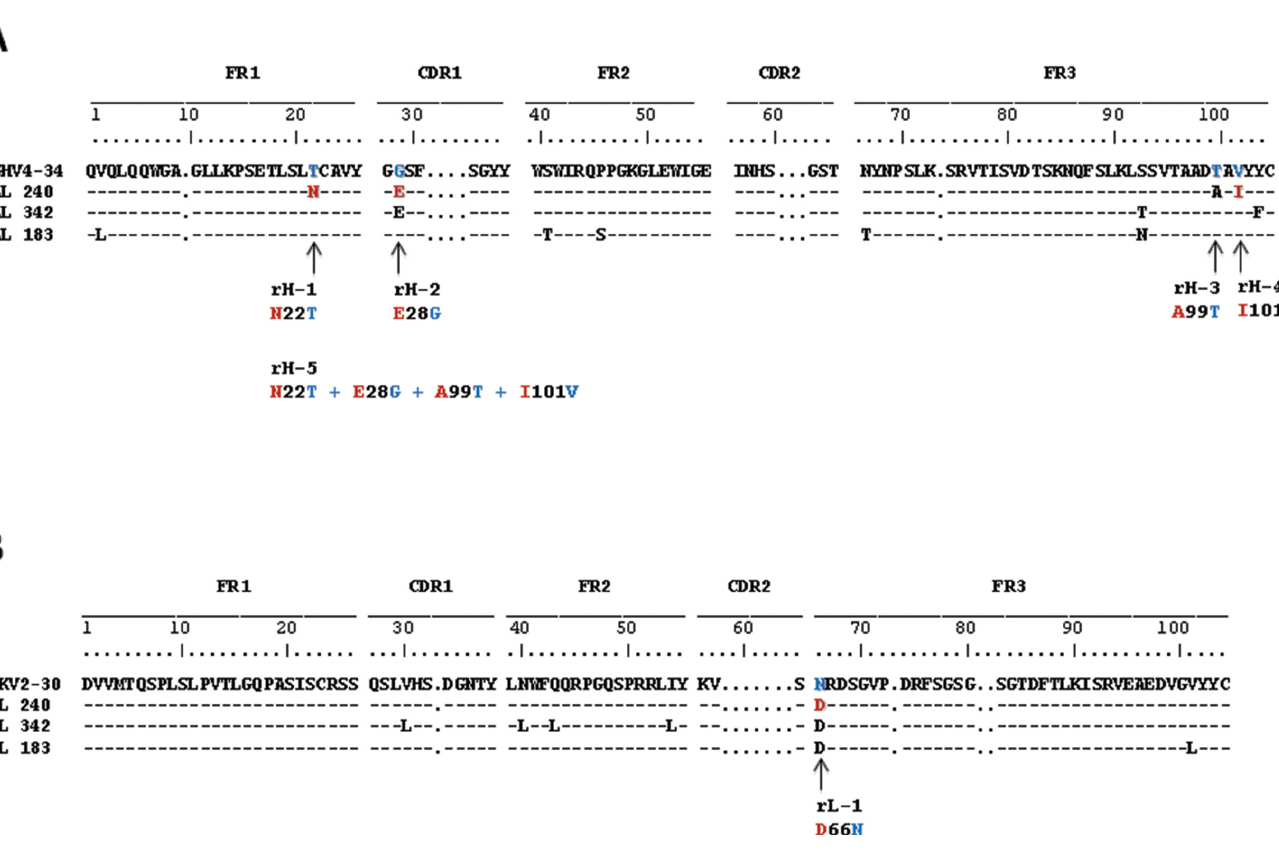
Figure 5. Sequences of the IGHV-D-J and IGKV-J rearrangements of subset 4 IGs and of the various IGHV4-34 and IGKV2-30 point rever- tants. The (A) IGHV4-34 - and (B) IGKV2-30 –encoded parts of the IG H and L variable domains of CLL subset 4 mAbs (nos. 240, 342 and 183) are aligned with the corresponding germline counterpart. H and L chain revertants are indicated by